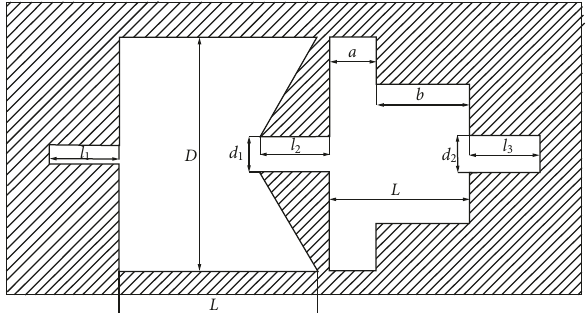
Figure 3: Diagram of the internal structure of the Helm- holtz+organ pipe cavitation nozzle.